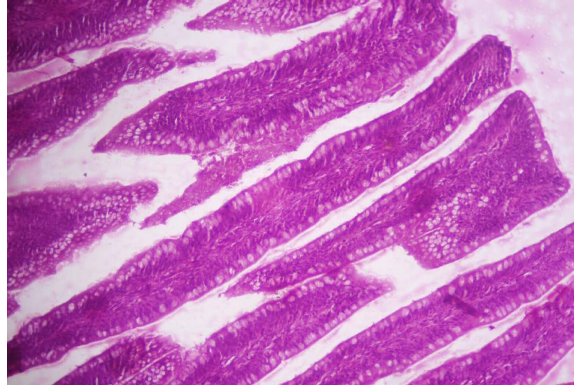
Figure-1. H & E section of duodenum showing broad villi at tip with Cost comparison: The cost of production per kg